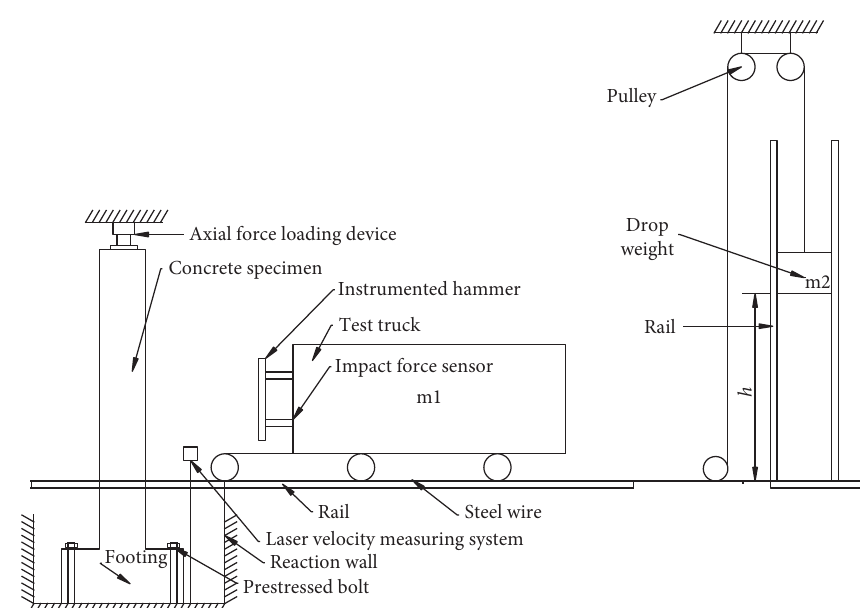
Figure 4: Multifunctional ultrahigh heavy drop hammer impact testing machine system.